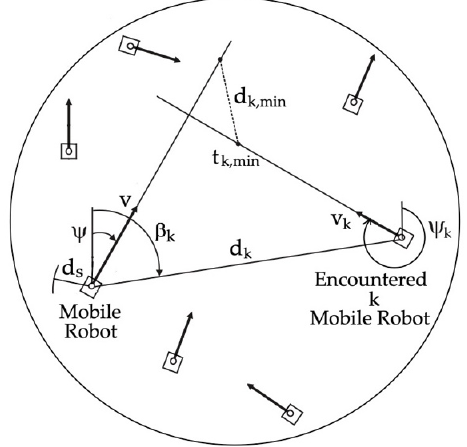
Figure 2. Illustrating the situation of a mobile robot with speed v and course ψ and the met k mobile robot moving with speed v k and course ψ k .